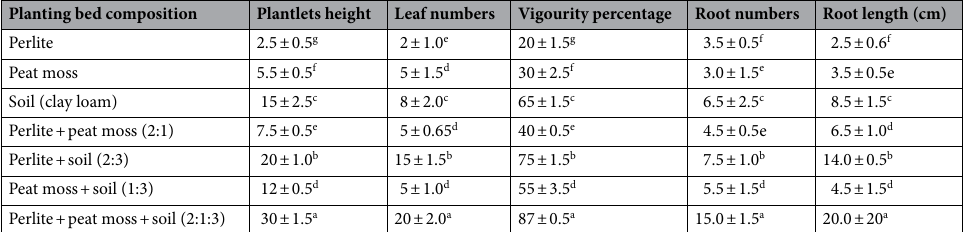
Table 5. The effects of planting bed compositions (perlite, peat moss, and soil) on the acclimatization of R. coriaria. Each value represents the mean ± SE of three replicates. Different lowercase letters in the same column indicated the significant difference at P ≤ 0.05; Different uppercase letters in the same column indicated the significant difference at P ≤ 0.01 (Duncan’s multiple range tests).